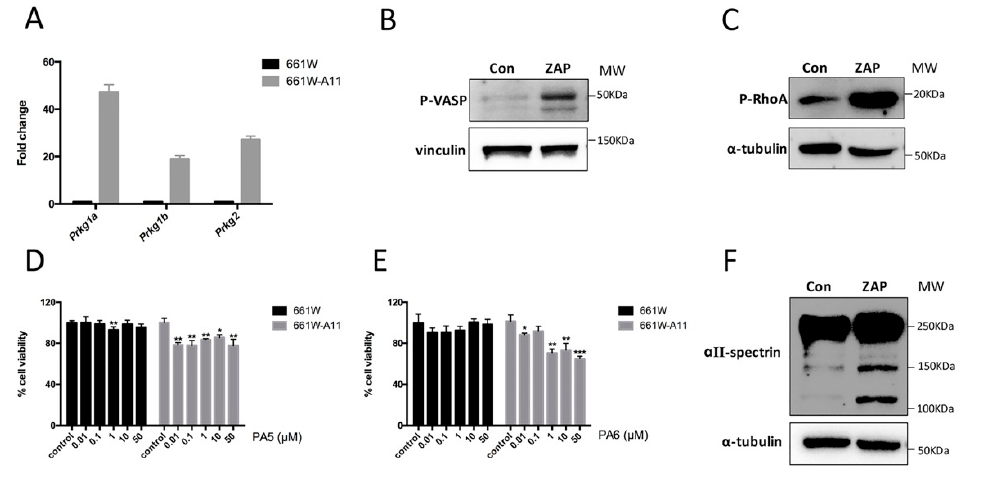
Figure 4. Activation of PKG and calpain proteases in 661W-A11. ( A ) Real-time qPCR analysis of Prkg1a , Prkg1b and Prkg2 mRNA in 661W-A11 cells compared with 661W cells. ( B , C ) Immunoblotting of phosphorylated VASP (P-VASP) and phosphorylated RhoA (P-RhoA) on control (Con: vehicle-treated) and zaprinast-treated (ZAP) 661W-A11 cells. ( D , E ) Cell viability assay, based on MTT, after treatment with increasing doses of PA5 ( D ) and PA6 ( E ). Values of 661W and 661W-A11 cells treated with the vehicle (H 2 O) were set as 100% cell viability. ( F ) Western blot analysis of the effects of α II-spectrin on the control and zaprinast-treated groups shows an increase in the 145–150 kDa fragments resulting from calpain cleavage and of the 120 kDa fragment resulting from caspase cleavage. Con: cells treated with DMSO; ZAP: cells treated with 400 μ M zaprinast for 24 h. Statistical comparison: Student’s unpaired two-tailed t -test; * p < 0.05, ** p < 0.01, *** p < 0.001.